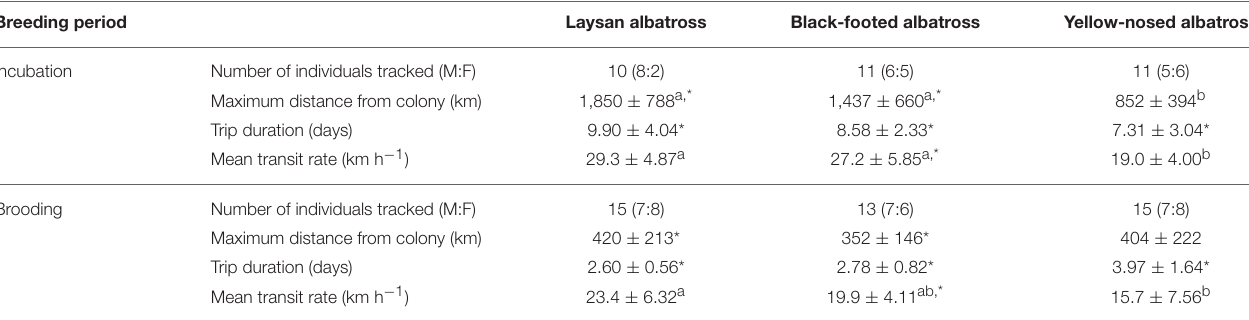
TABLE 1 | Summary characteristics (Mean ± SD ) of foraging trips of Laysan and black-footed albatrosses tracked at Tern Island, Northwest Hawaiian Islands, and Indian yellow-nosed albatrosses tracked at Amsterdam Island, southern Indian Ocean, during late incubation and brooding. Breeding period Laysan albatross Black-footed albatross Yellow-nosed albatross Incubation